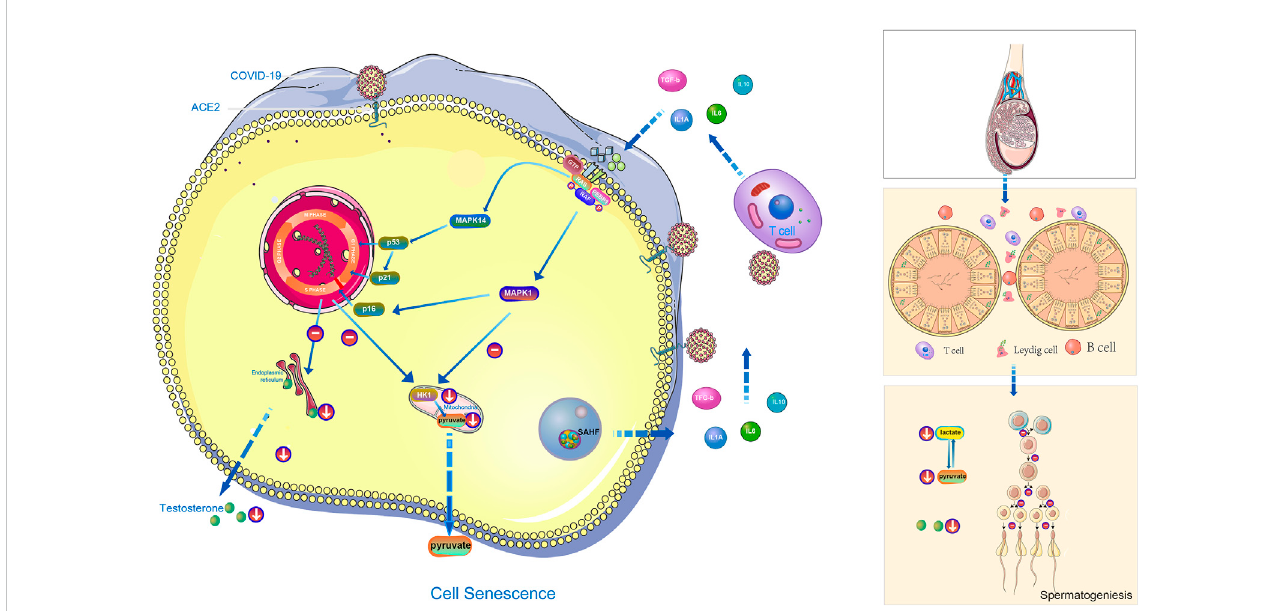
FIGURE 7 The hypothetical diagram of the results in this study. In COVID-19 infection,COVID-19 can induce testicular cell senescence through MAPK signaling pathway (upper right and middle position of left half fi gure), and cellular senescence synergize with MAPK pathway to further affects the normal synthesis of cholesterol and androgen (lower right and middle position of left half fi gure), and to inhibits normal synthesis of lactate and pyruvate (Right below the left half fi gure), ultimately affects male spermatogenesis (Right half diagram, from top to bottom is the structure of testis, seminiferous tubules and their surrounding environment, spermatogenesis